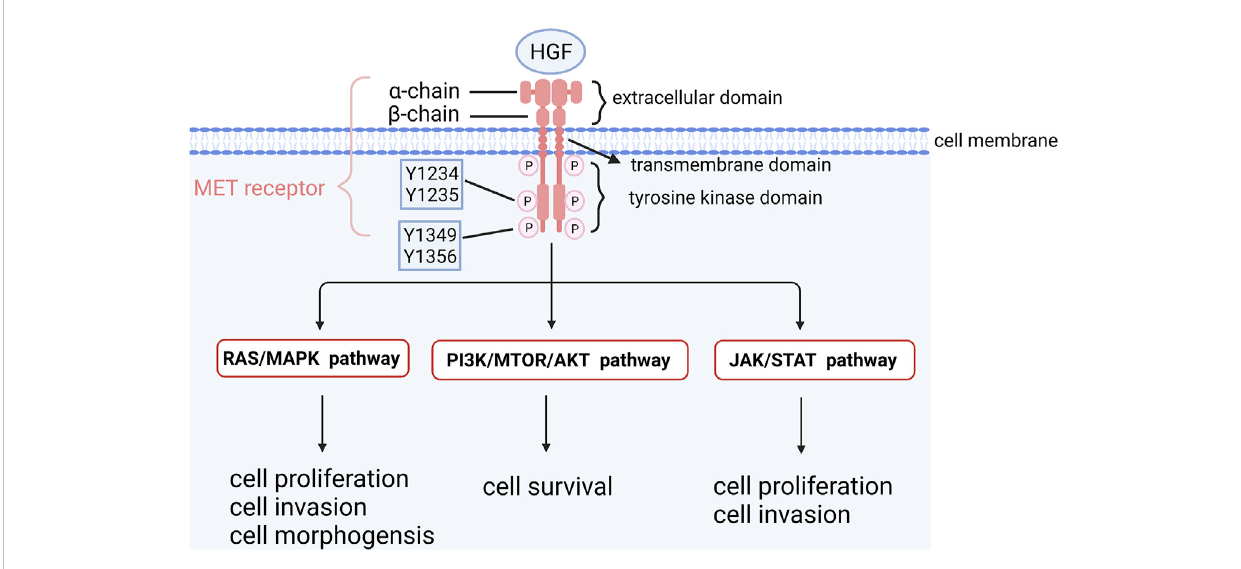
FIGURE 3 The structure of MET and its downstream signaling pathways. HGF binds to MET and regulates kinase activity by inducing homodimerization and phosphorylation of Y1234 and Y1235, two catalytic sites of tyrosine residues in MET receptor. Phosphorylated carboxyl terminal containing Y1349 and Y1356servesasdockingsitesforintracellularproteinkinases,transmitssignalsdownstreamandactivatesRAS-MAPKsignalingpathway,PI3K/AKT/mTOR signaling pathway and other pathways to promote cell proliferation and